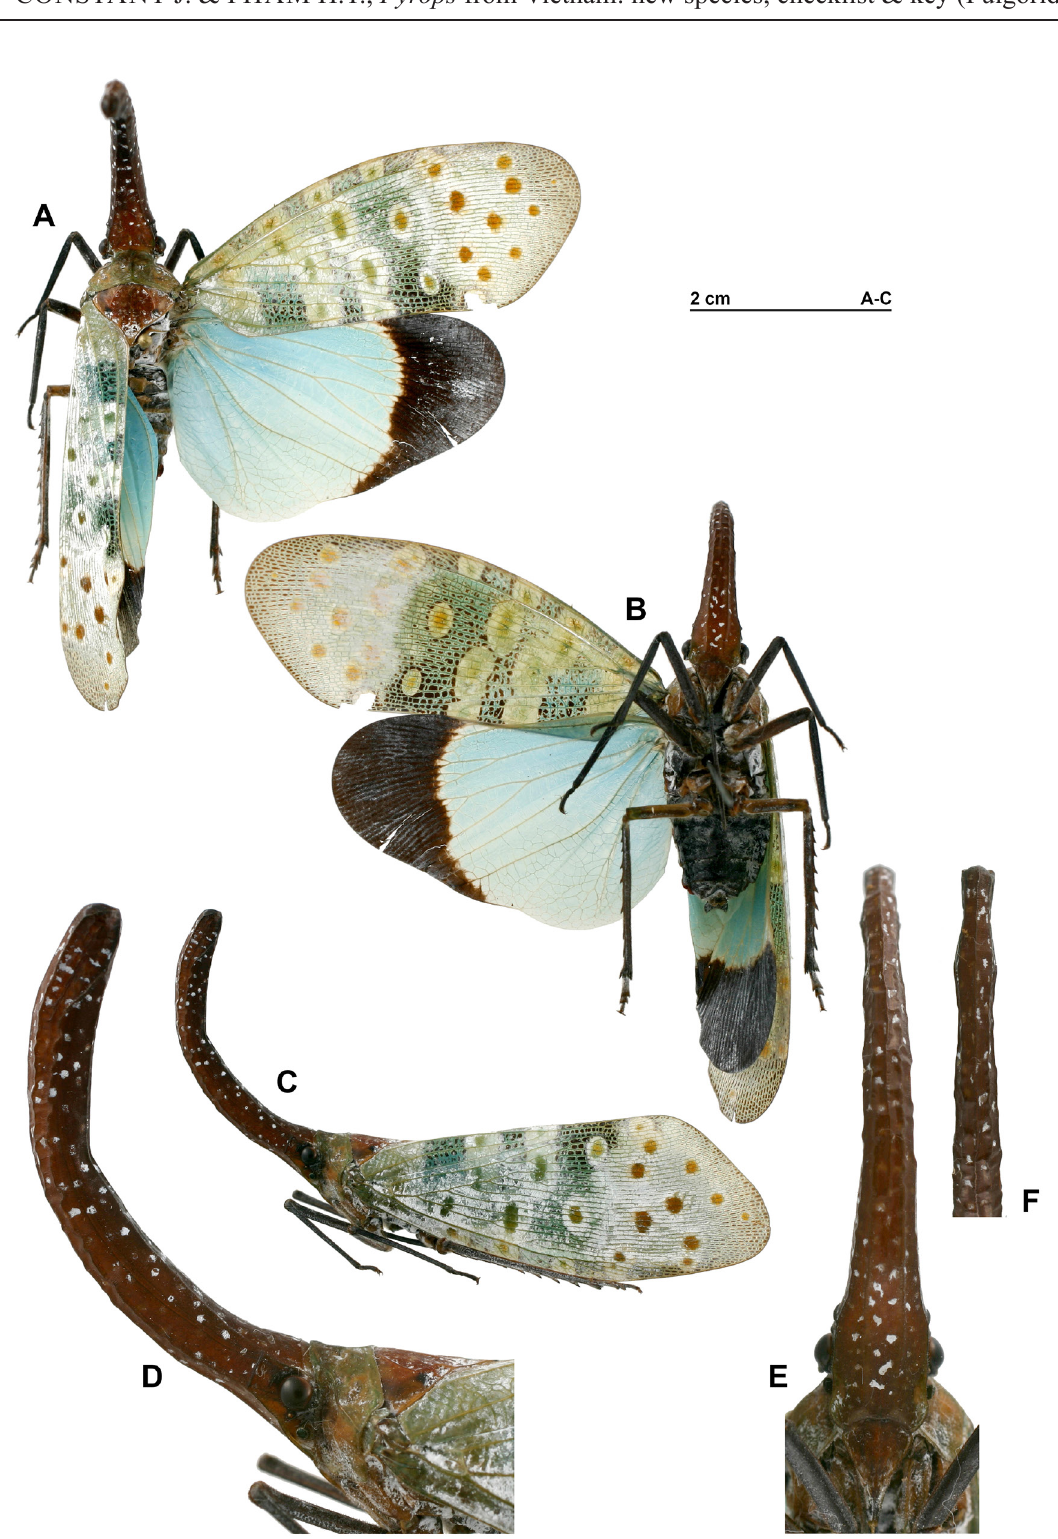
Fig. 18. Pyrops coelestinus (Stål, 1863), ♀, Vietnam, Dong Nai Prov., Vinh Cuu, Phu Ly, 27 Jul. 2008 (VNMN). A . Habitus, dorsal view. B . Habitus, ventral view. C . Habitus, lateral view. D . Head and thorax, lateral view. E . Head, perpendicular view of frons. F . Apex of cephalic process, anteroventral view. D–F = not to